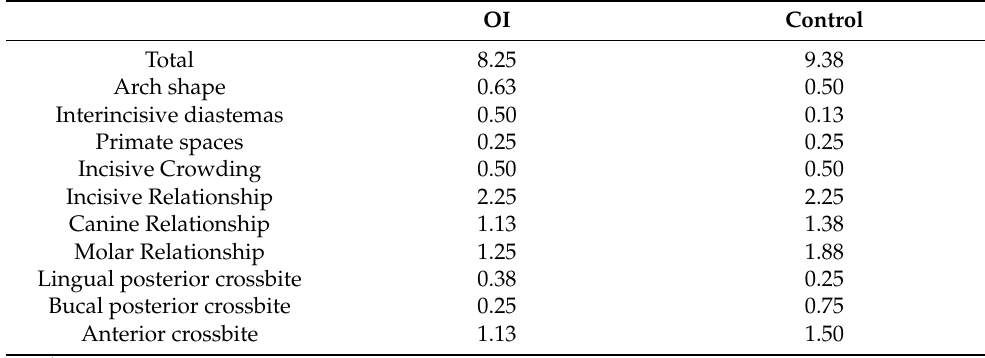
Table 4. Results of comparative analysis of occlusion in primary dentition in OI and control groups. Osteogenesis Imperfecta (OI).